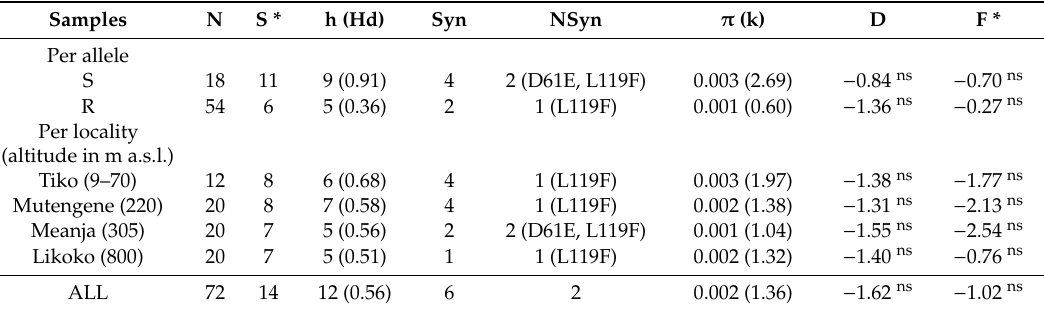
Table 1. Genetic variability parameters of GSTe2 full